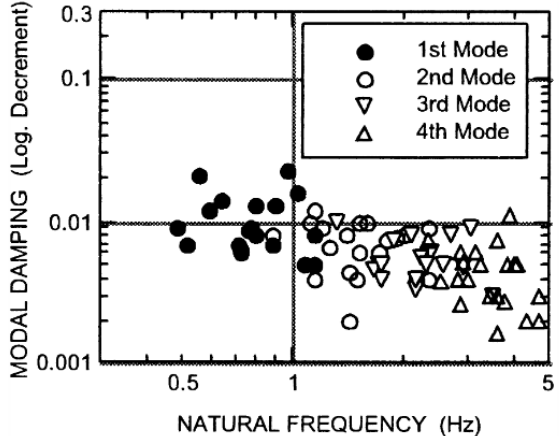
Fig. 1 . Relation between modal damping and natural frequency in stay cables